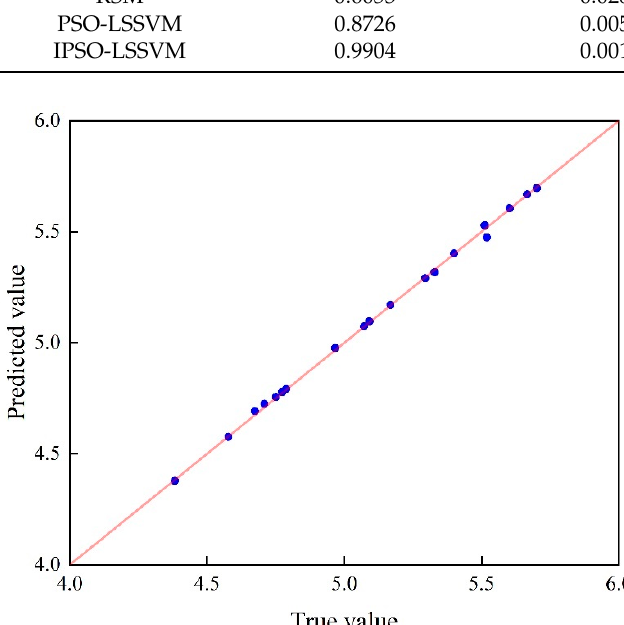
Figure 8. Comparison between the predicted and true value of K c .